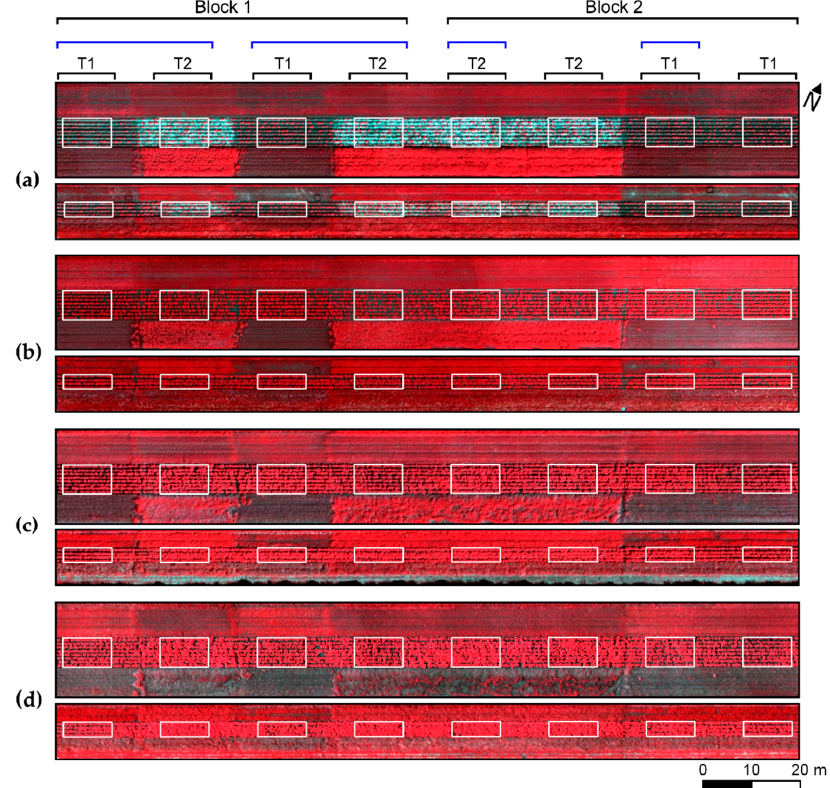
Figure 1. Distribution of experimental plots and treatments (T1, non-mixed system; T2, mixed system) in the study site. Figures correspond to false color composite (735, 631, and 609 nm as RGB bands) for UAV imagery acquired 37 ( a ), 50 ( b ), 64 ( c ), and 78 ( d ) days after planting (DAP). White boundaries indicate small and large experimental plots. Original experimental arrangement is indicated by black connectors and new blocks used for treatments comparison (as described in Section 2.6) are indicated in